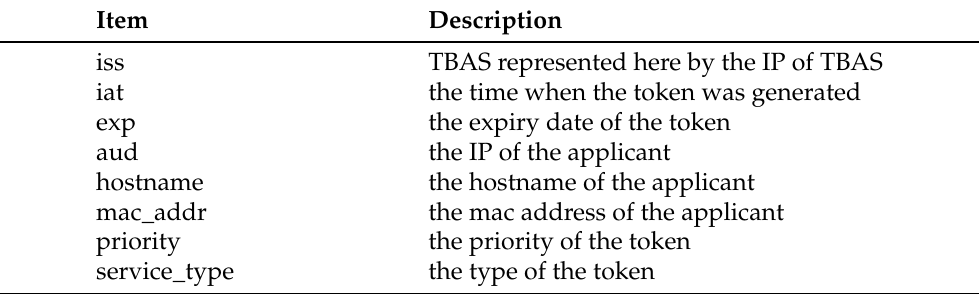
Table 2. The information of